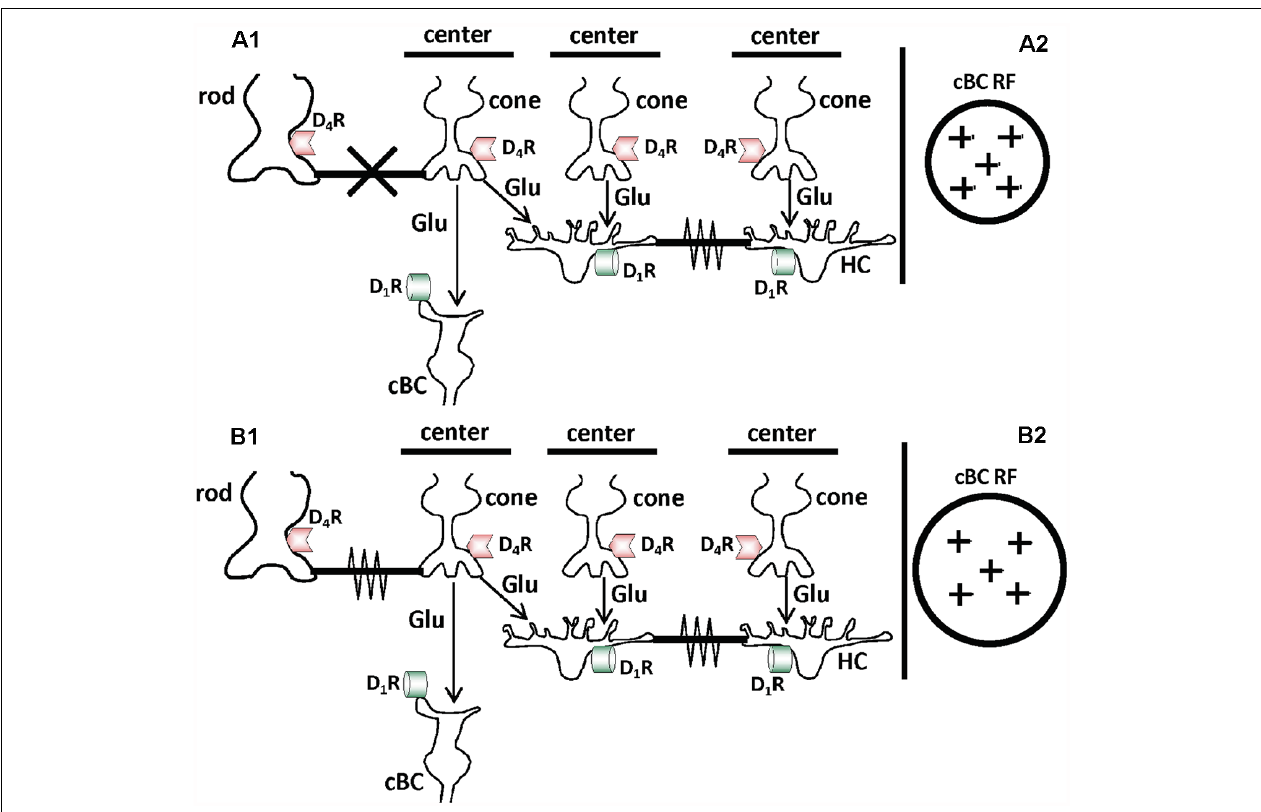
FIGURE 8 | Schematic diagrams showing that the retinal circadian clock, by regulating activation of D 4 receptors on cones and rods, controls electrical synaptic signaling between rods and cones and the receptive field size of cones. (A1,B1) Cell types, transmitter receptors, and gap junctions are the same as in Figure 1 , but the retinal clock regulates their expression and function in day and night differently compared to the effects of background illumination. The different effects of the retinal clock and background illumination occur because the circadian clock and light activate D 4 Rs and D 1 Rs, respectively ( Figure 2 ). Although the retinal clock releases less dopamine in the day than bright light, circadian clock-induced dopamine release in the day is sufficient to activate cone D 4 Rs (but not D 1 Rs; Figure 2 ). This is because D 4 Rs are ∼ 500 times more sensitive to dopamine than D 1 Rs. In constant darkness at night, dopamine levels are lower than in the day and not sufficient to activate cone D 4 Rs. The retinal clock, therefore, controls D 4 R-mediated phenomena such as rod-cone coupling but not D 1 R-mediated effects such as GABA A R expression and function on cBC dendrites and gap junction coupling between HCs. As a result, in maintained darkness in both day and night when D 1 Rs are not activated, cBC dendrites lack GABA A Rs, HC gap junctions are open, and cBCs lack receptive field surrounds. (A1,A2) Following maintained darkness in the day, the retinal clock releases sufficient dopamine to activate D 4 Rs in cones and rods, which decreases cAMP/PKA in the cells. As a result, gap junctions between rods and cones are closed (A1) . The RF center of cBCs is large because they lack RF surrounds due to the lack of GABA A Rs on its dendrites. However, the RF center of cBCs may not be as large as at night (A2) . (B1,B2) Following maintained darkness at night, the retinal clock does not release enough dopamine to activate D 4 Rs in cones and rods, which increases cAMP/PKA in the cells. As a result, gap junctions between rods and cones are open (B1) . Evidence indicates that the RFs of cones are larger at night in the dark than in the day in the dark due to increased photoreceptor coupling. It is hypothesized that the RF center of cBCs is therefore larger at night in the dark than in the day (B2)